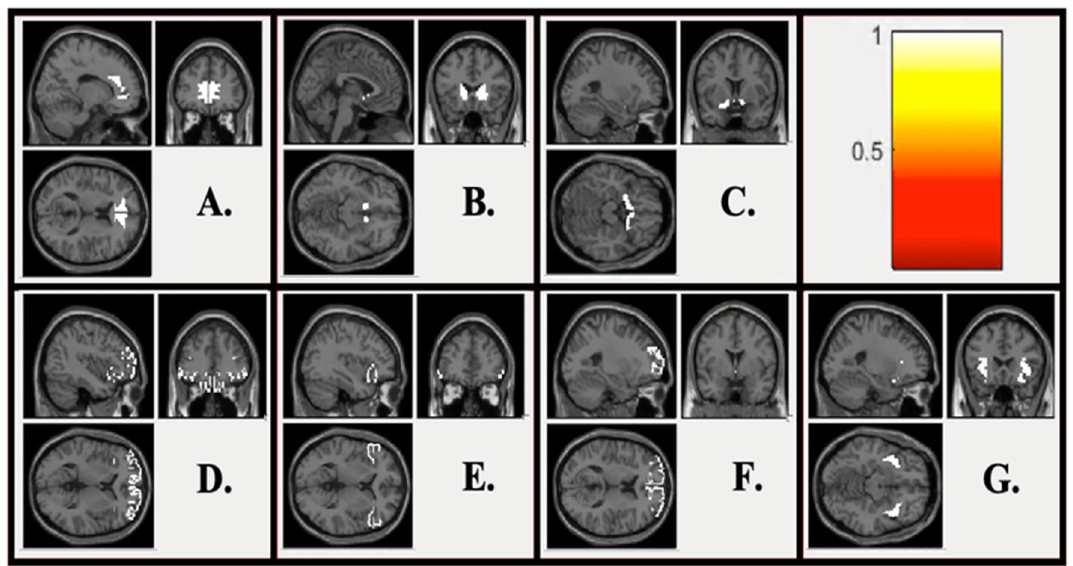
Figure 2. Region of Interest (ROI) maps. ( A ) Anterior cingulate cortex ROI; ( B ) Dorsal striatum ROI; ( C ) Ventral striatum ROI; ( D ) Orbitofrontal cortex ROI; ( E ) Ventrolateral prefrontal cortex ROI; ( F ) Ventromedial prefrontal cortex ROI; ( G ) Insula ROI. Table 2. Associations between NSSI status and neural responses to negative and positive outcomes in a priori ROIs.